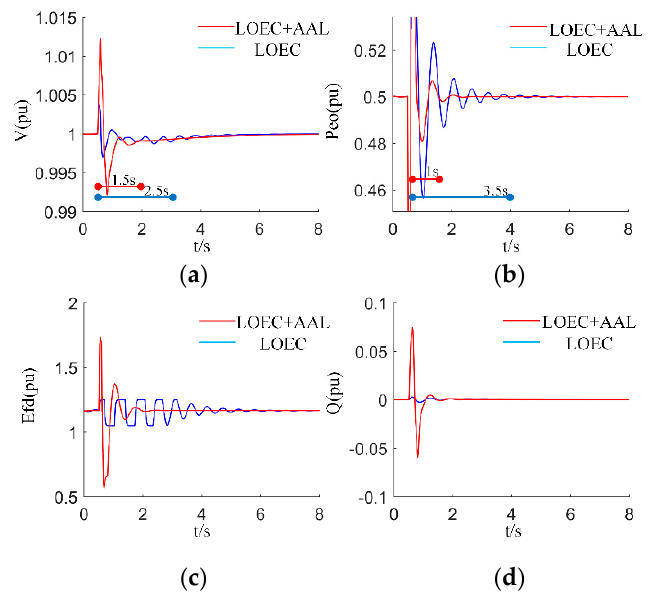
Figure 11. Comparison of coordinated control and traditional control under the disconnection fault. ( a ) terminal voltage ( b ) active power ( c ) field voltage ( d ) reactive power injection.